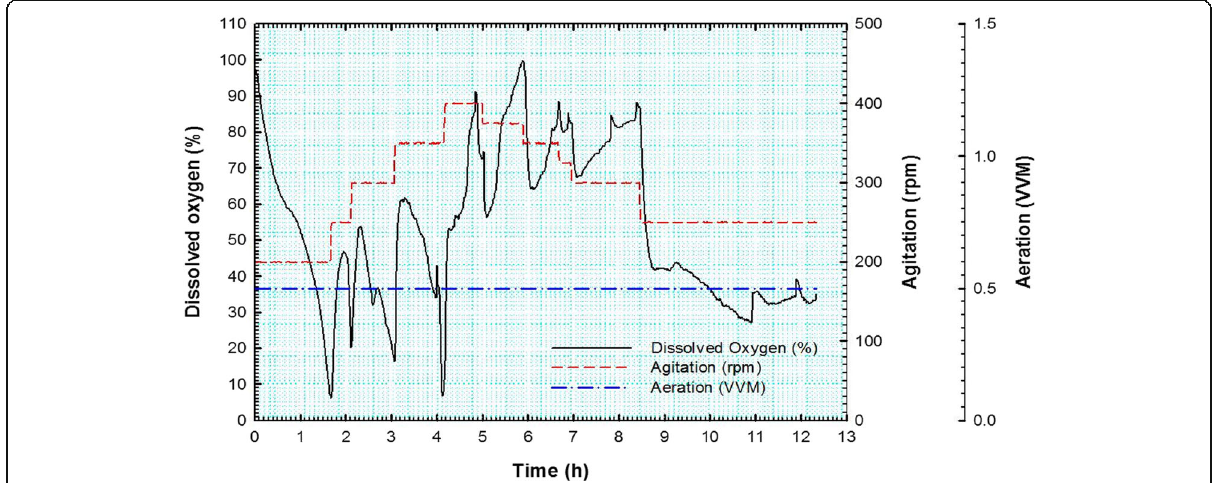
Fig. 7 Dissolved oxygen, agitation, and aeration as a function of time during batch fermentation no. 1 of Bacillus subtilis isolate B10